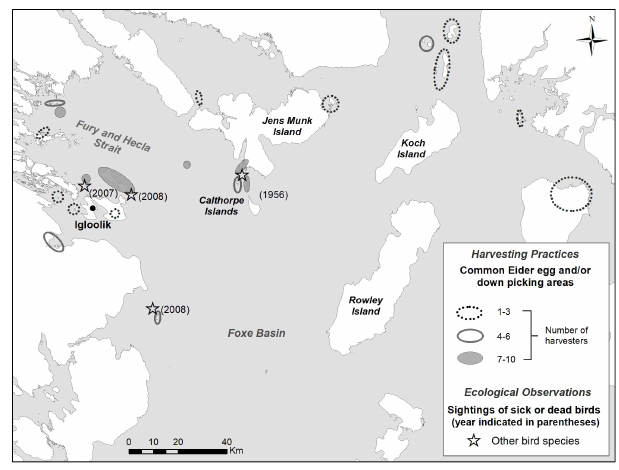
Fig. 6 . Participants’ use of the Common Eider ( Somateria mollissima ) and observations of sick or dead Common Eiders and other birds in Igloolik,